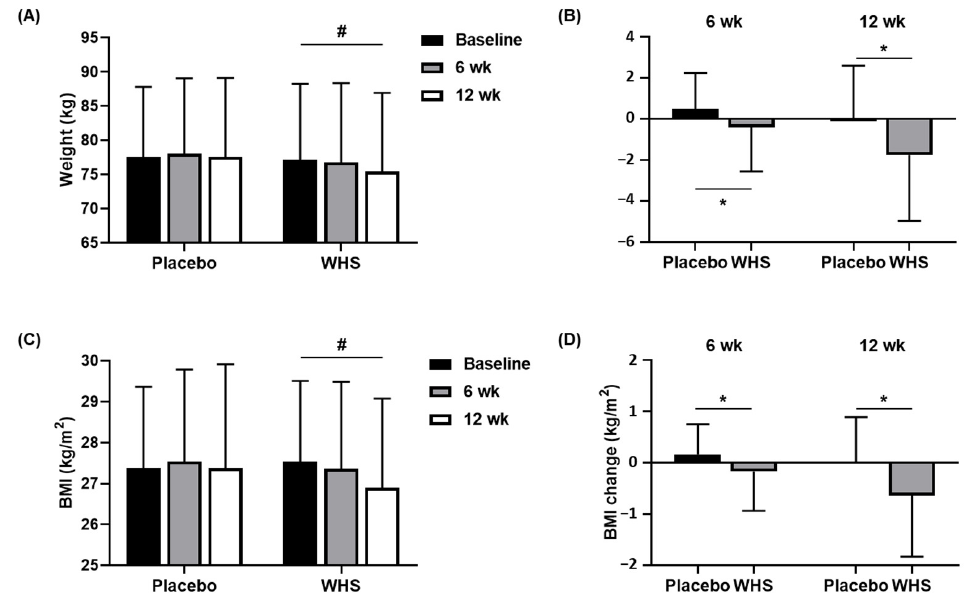
Figure 4. Changes in body weights and BMIs. Changes in ( A , B ) weight and ( C , D ) BMI were measured in placebo- and WHS-treated groups at baseline, 6, and 12 weeks. Values are present as mean ± SD; # p < 0.05 derived from paired t -test within groups (Weeks 0 vs. 12), and * p < 0.05 derived from a two-sample t -test or Wilcoxon rank-sum test between groups (Placebo ( n = 45) vs. WHS ( n = 48)).